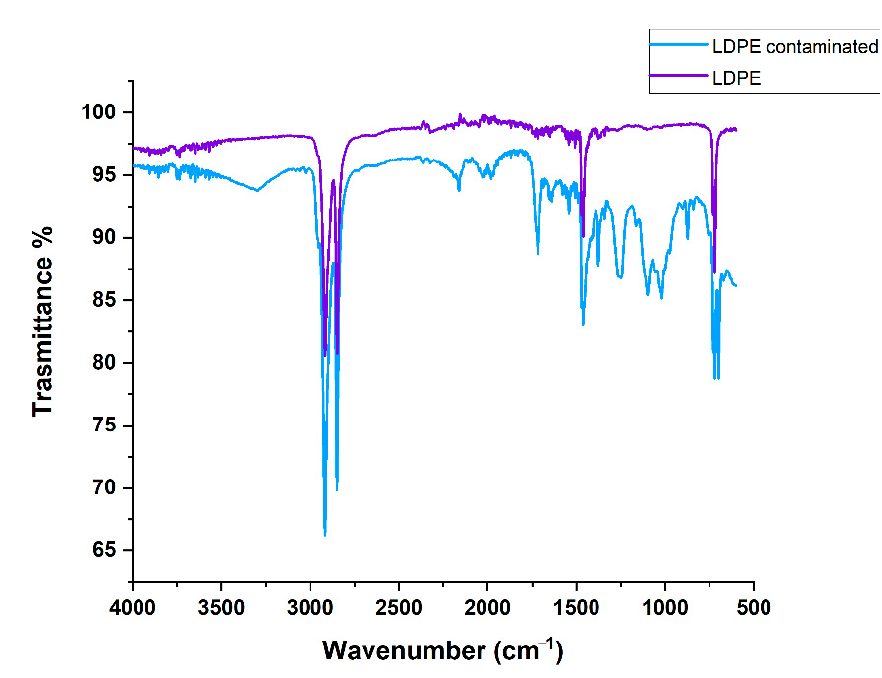
Figure 2. IR spectra of the floating fraction of the feedstock: LDPE (violet line) and polyethylene contaminated with aromatic polyester (light blue line).